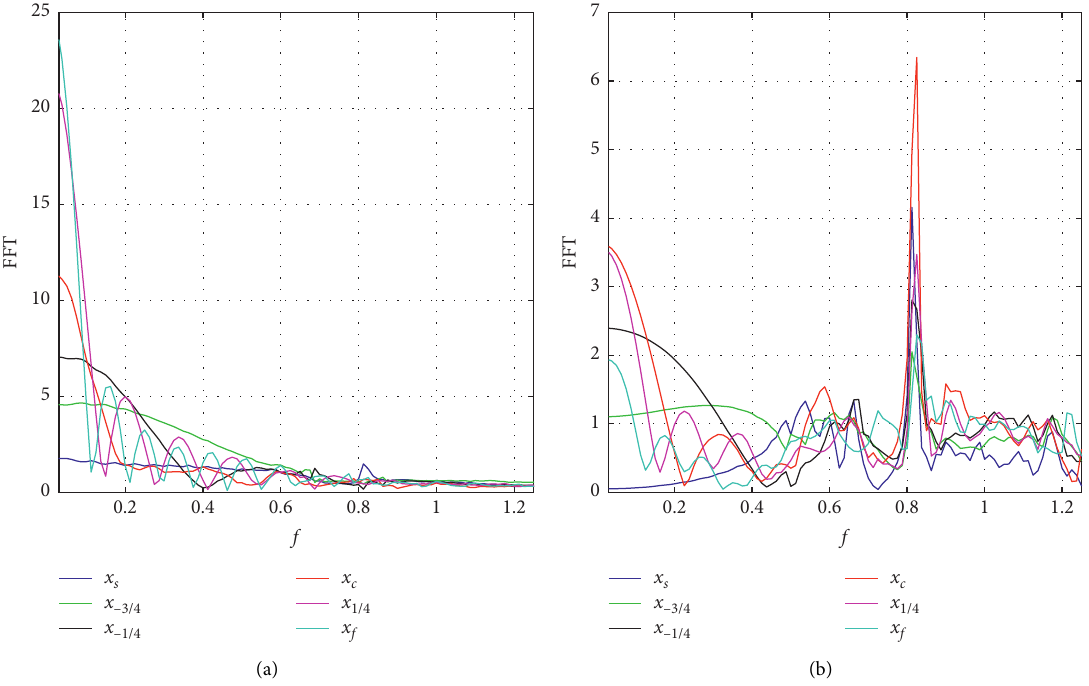
Figure 7: Fourier spectrum (wavenumbers domain) for (a) v static no radiating field artificial peak around k s � 0 while that of (b) well-defined peaks k s ≃ 0 . 82 corresponds to optical eigenmodes of